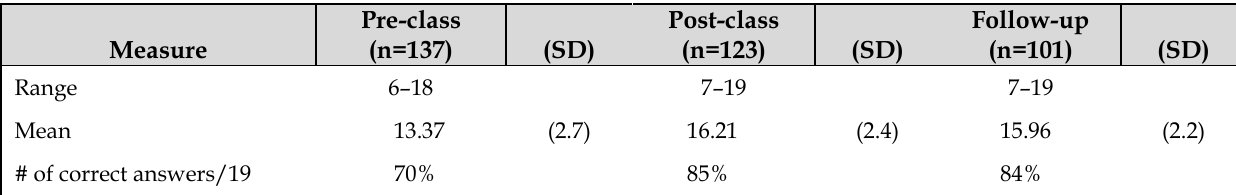
Table 2 Comparison of total knowledge scores over